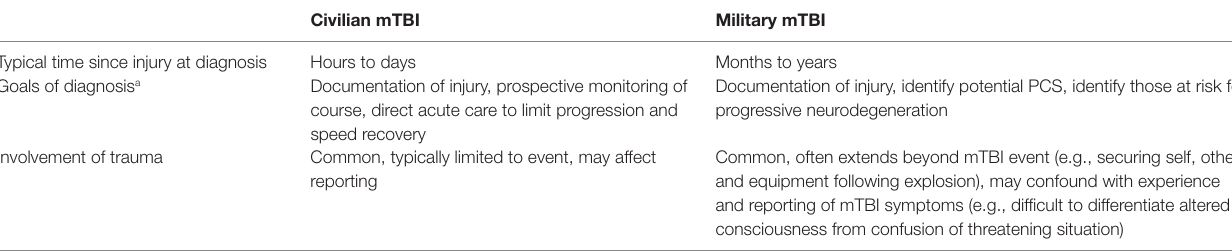
tABLe 1 | summary of key points of comparison between civilian and military